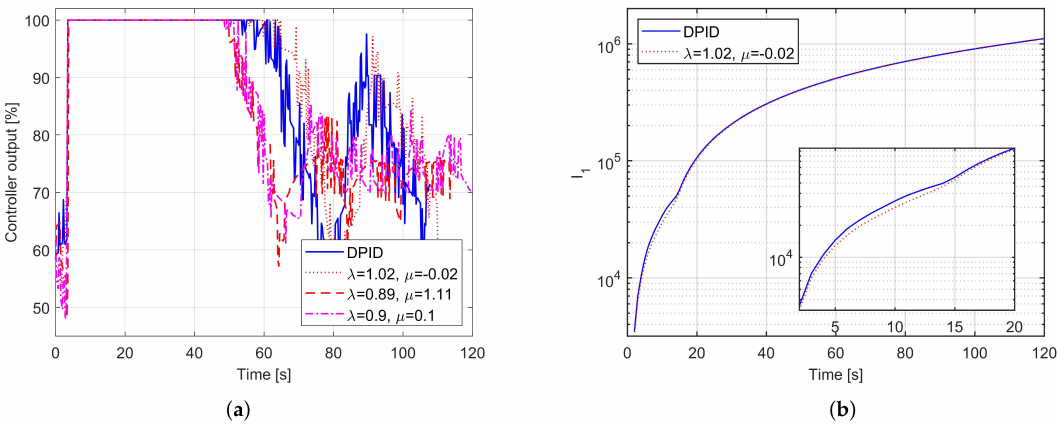
Figure 16. Comparison of controllers outputs, sampling time 0.15 s. ( a ) Controllers’ outputs; ( b ) cost function of the controllers’